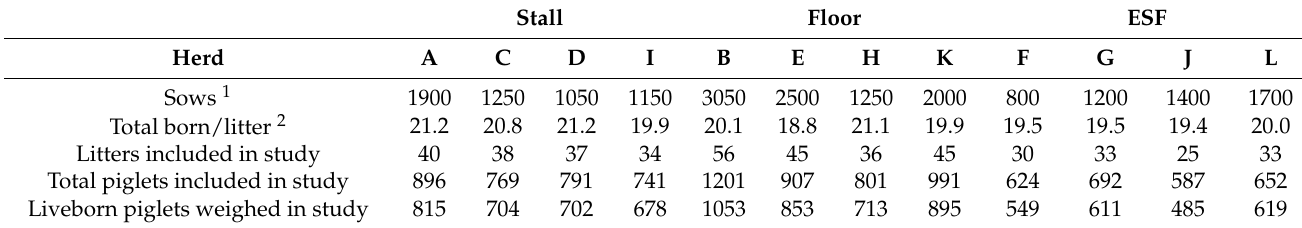
Table 1. Feed system, number of sows, average level of total born per litter and number of litters and piglets in the study of the individual herds (presented by letters A–L). Stall describes free-access feeding stalls, Floor describes floor feeding and ESF describes electronic sow feeding